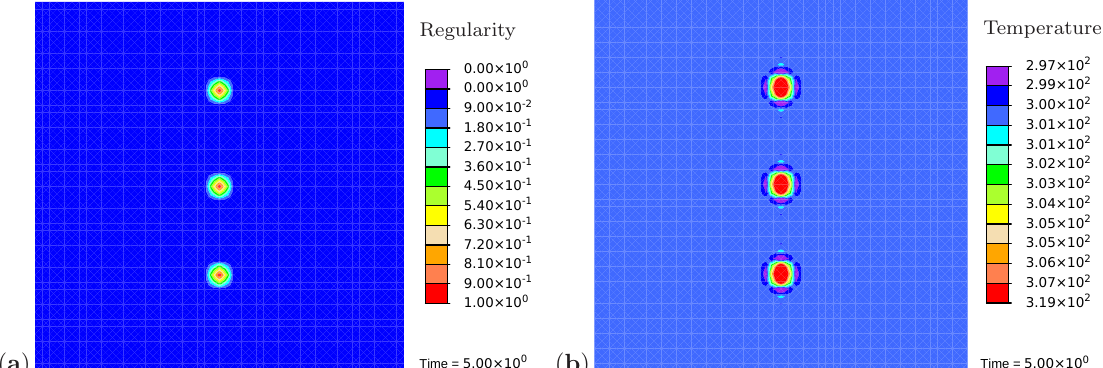
Figure 7. Simulation of the cyclic tensile test for a sample with three nuclei. Snapshots of the microstructure evolution at the end of the loading stage (¯ λ = 6.0) showing ( a ) regularity distribution and ( b ) temperature distribution (in